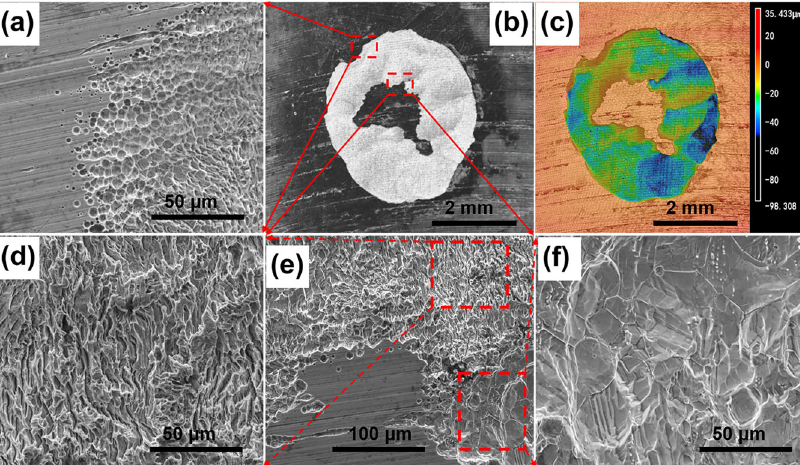
Fig. 10 Corrosion morphologies caused by a single barnacle. b the whole area, a , d , e , f local magni fi cation area, c topographic pro fi